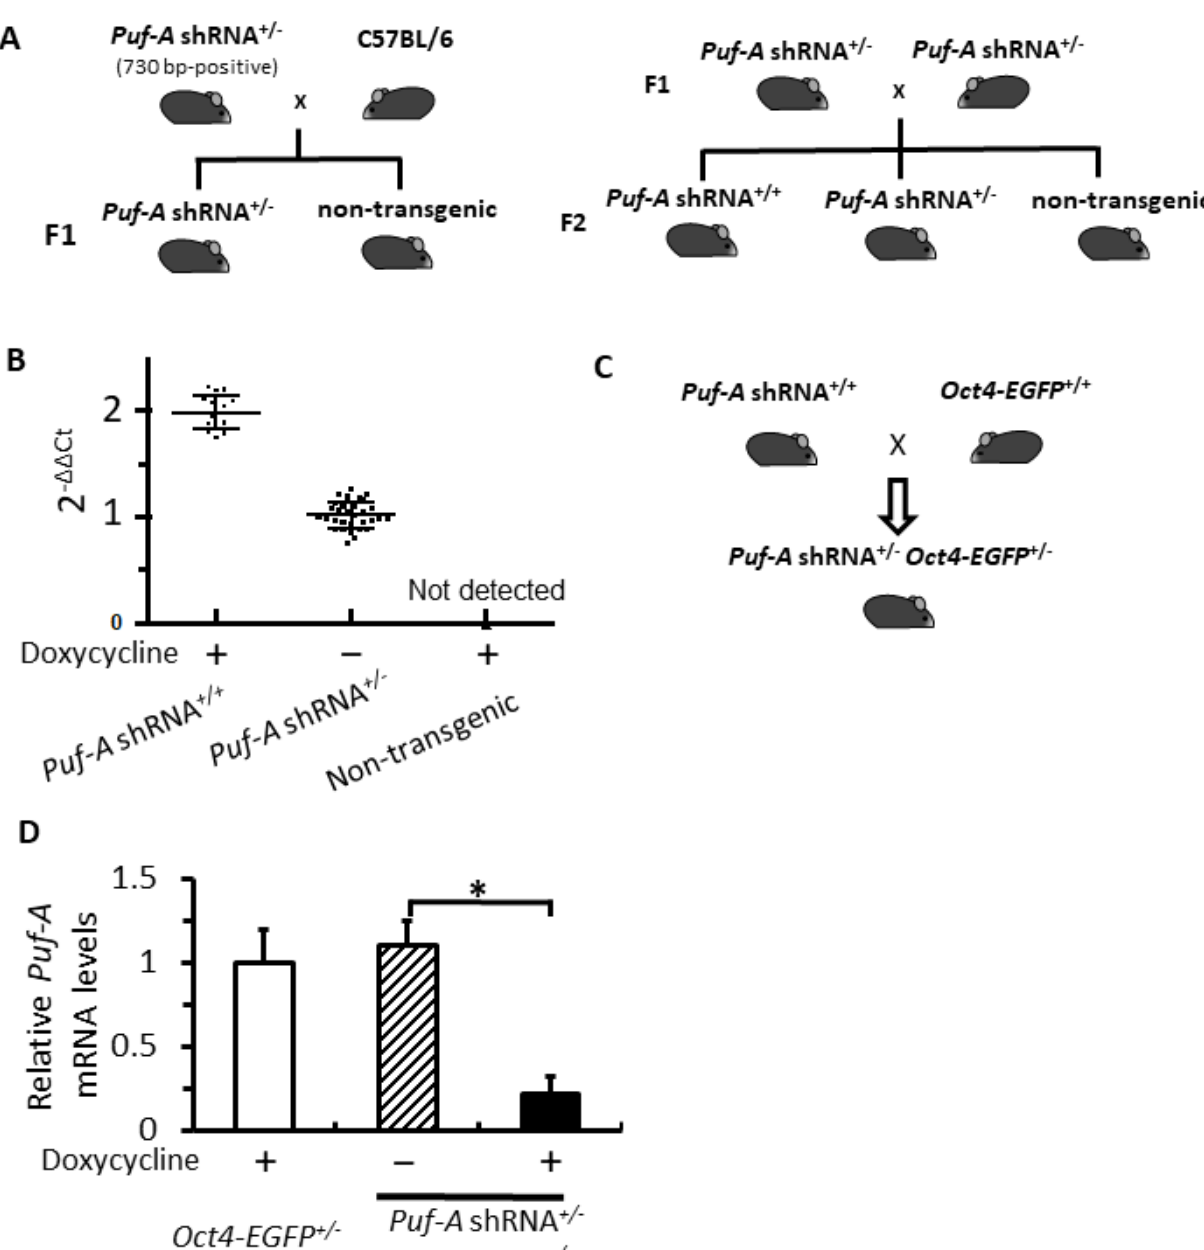
Figure 2. Generation of the inducible Puf-A shRNA and Oct4-EGFP double transgenic mice. ( A ) Breeding scheme of the Puf-A shRNA homozygous transgenic mice. ( B ) The real-time qPCR reactions for Puf-A shRNA transgene using primers #3 and #4 in Figure 1A were performed using genomic DNA of the F2 mice and normalized to GAPDH gene. Each dot represented the qPCR result from one mouse. The data are shown as mean ± SD. ( C ) Breeding scheme to generate the double transgenic mice of Puf-A shRNA +/– Oct4-EGFP +/– . ( D ) qRT-PCR analysis for Puf-A in PGCs from E10.5 embryos. The PGCs from Puf-A -silencing embryos exhibited approximately 80% knockdown of Puf-A mRNA expression. The data are presented as mean ± SD (* p < 0.05, n = 3).